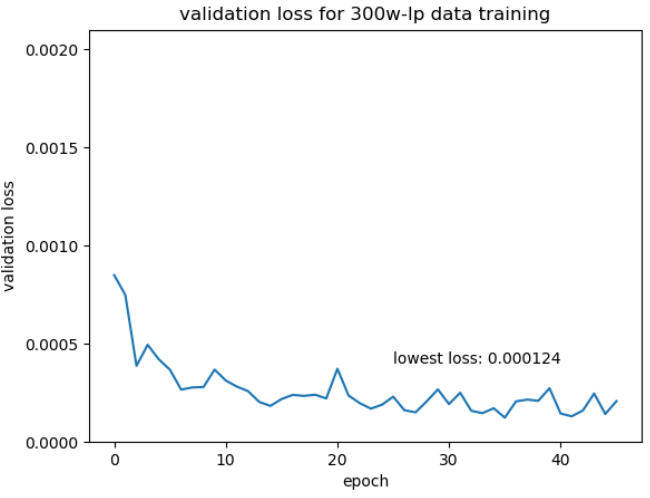
Figure 13. Validation loss over transfer